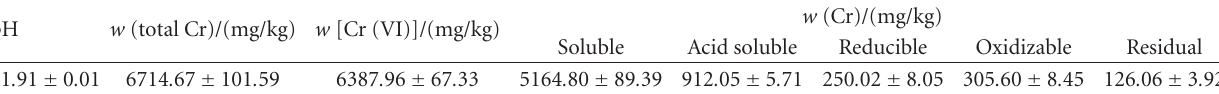
Figure 3: Content of total Cr and Cr (VI) and the pH in solid sample after water washing. Table 1: Physicochemical properties of the